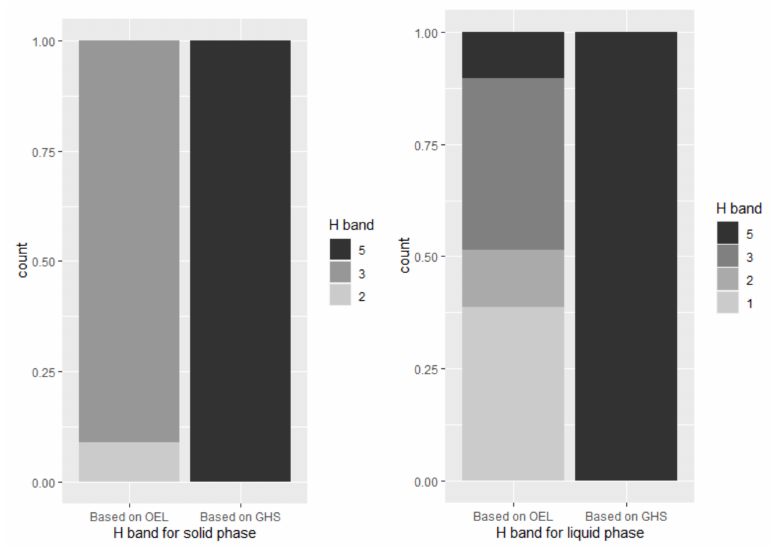
Figure 4. Hazard band (H band) for each phase and branch based on available information.